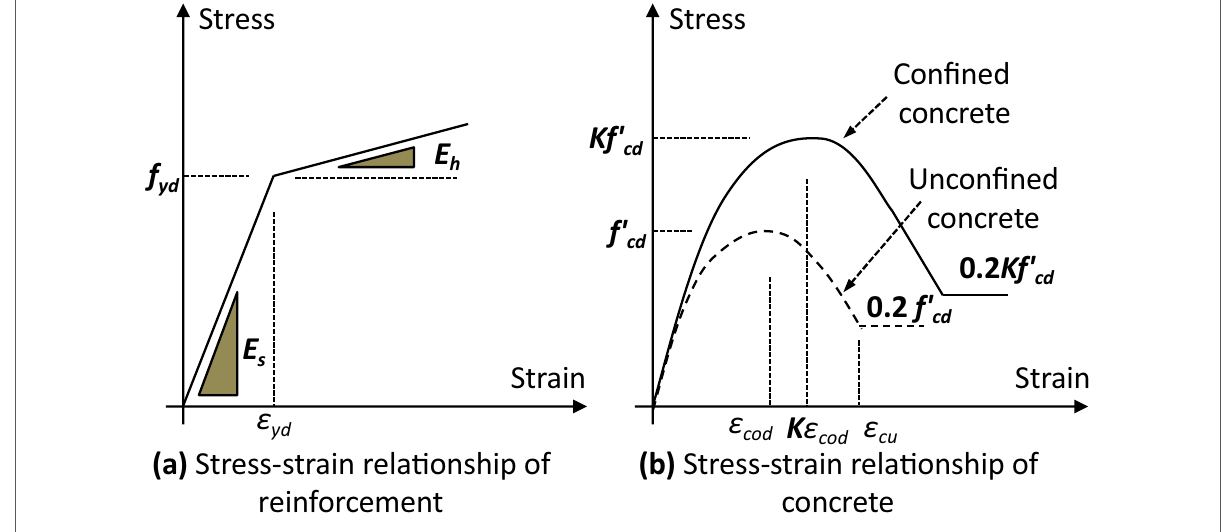
Fig. 10 Stress–strain relationships of reinforcing bar and